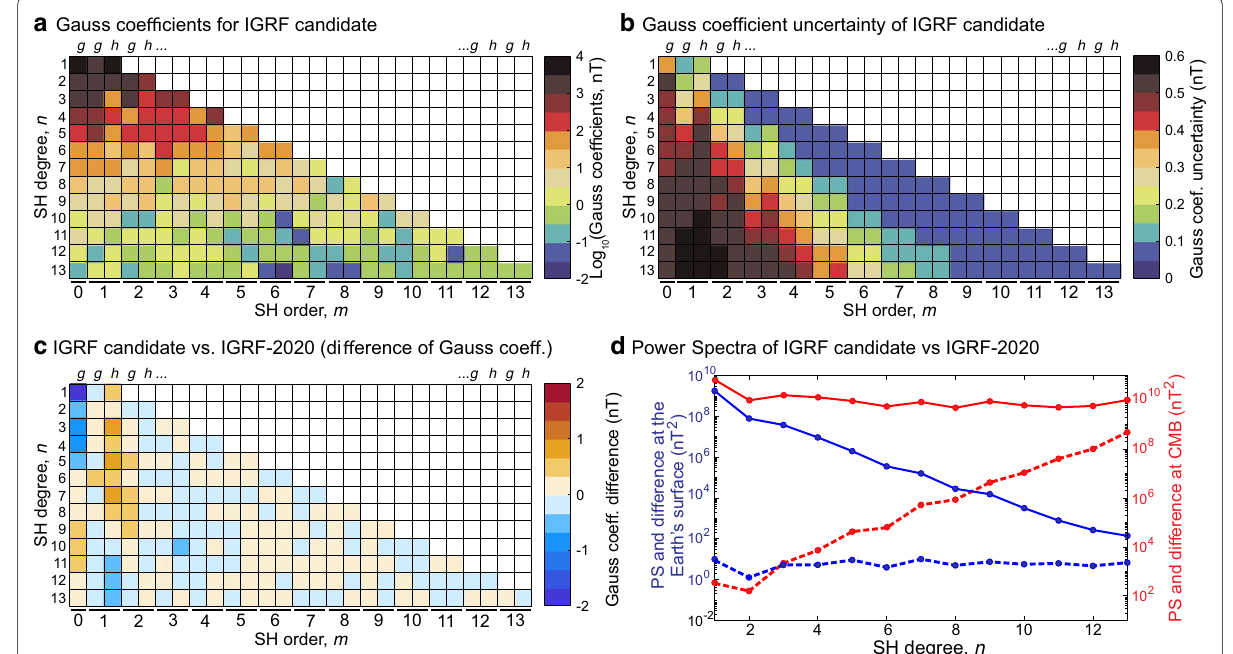
Fig. 11 IGRF candidate model. a Gauss coefficients and b the uncertainties given by the 1‑σ of their normal distributions. c Gauss coefficient differences between our IGRF candidate and the published IGRF‑2020 model. d Power spectrum at the Earth’s surface (blue line referred to the left y ‑axis) and at the CMB (red line referred to the right y ‑axis). Differences of the power spectrum between our candidate and the IGRF‑2020 model is also given by dashed lines (blue at Earth’s surface and red at